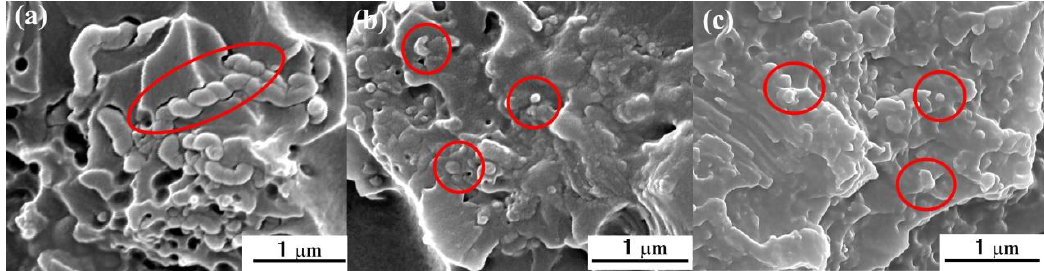
Figure 8. SEM images of the fracture surface of HCNT/epoxy composites with 0.6 wt % P-HCNTs ( a ), A-HCNTs ( b ), and K-HCNTs ( c ) after the three-point bending test. Red solid circles indicate the locations of HCNTs.